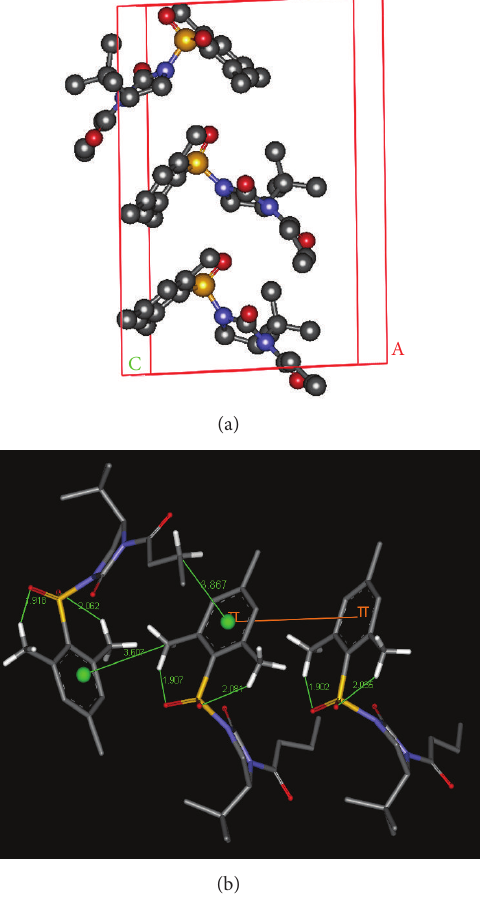
Figure3:Crystalpackingofcompound 3 (a).(b)Showsintermolec- ular CH-O, CH- 𝜋 (green lines), and 𝜋 - 𝜋 interactions (orange line). Hydrogen atoms are omitted for clarity except hydrogen included in CH-O